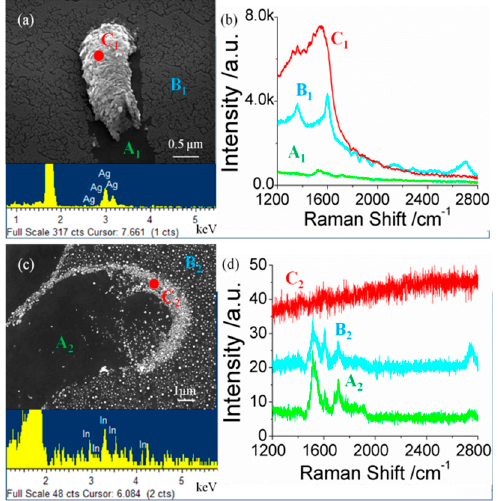
Figure 4. SEM image and corresponding Raman spectroscopy. ( a , b ) For Ag/EG system, inside trench, Ag film without sliding and the trench head are marked by A1, B1 and C1, respectively. ( c , d ) for In/EG system, inside trench, In particles without sliding and the trench head are marked by A2, B2 and C2, respectively. EDS results are displayed in the insets.